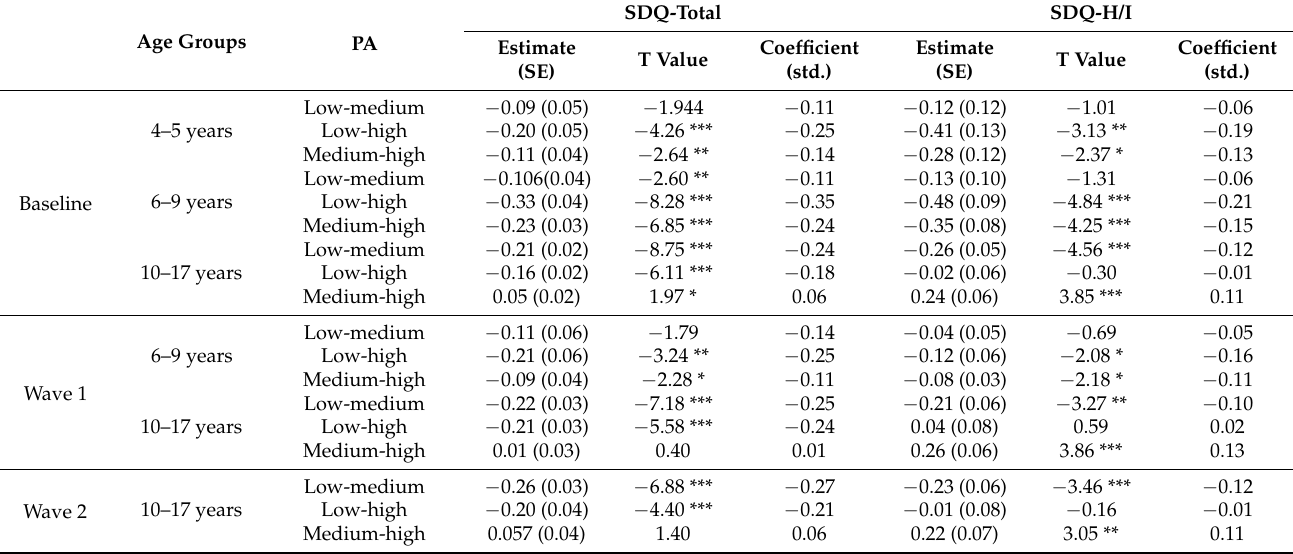
Table 4. Results at baseline, wave 1, and wave 2 showing associations of physical activity (PA), mental health problem (Strengths and Difficulties Questionnaire [SDQ] total), and ADHD symptoms (SDQ hyperactivity/inattention subscale